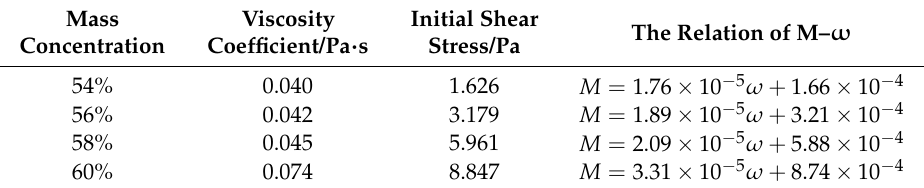
Table 4. Slurry parametric test.